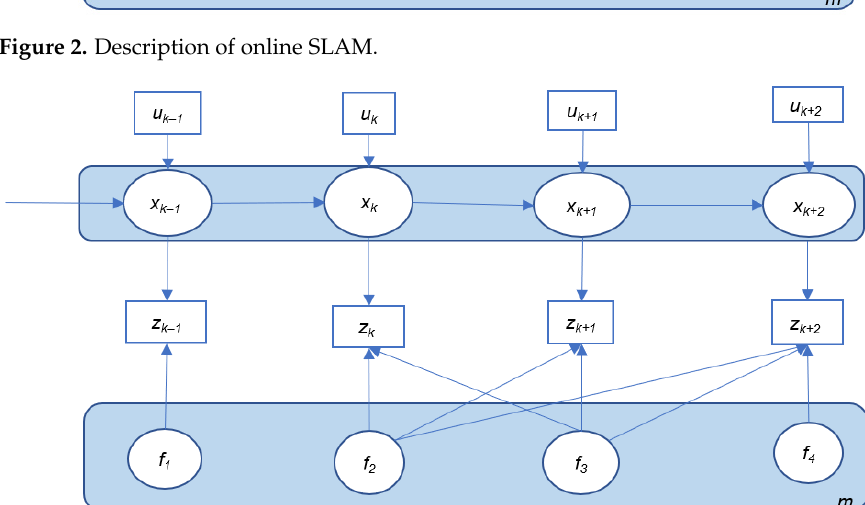
Figure 3. Description of offline